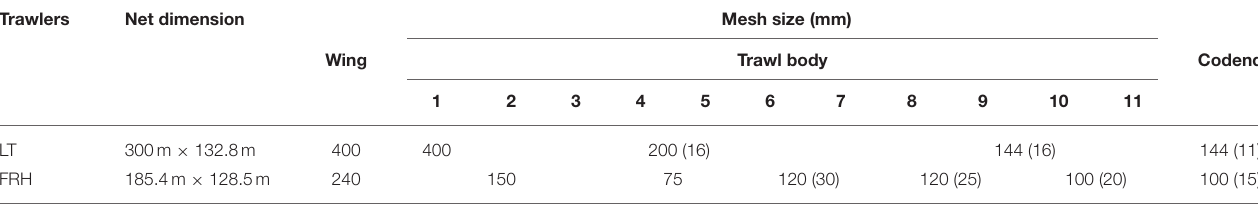
TABLE 1 | Information on the trawls of trawlers Long Teng (LT) and Fu Rong Hai (FRH). Trawlers